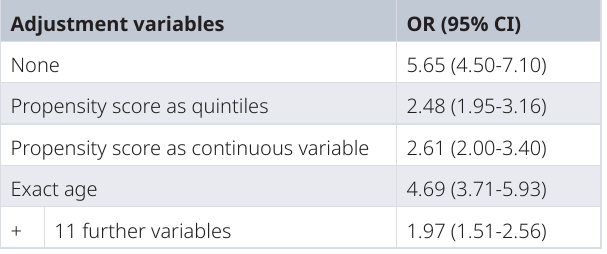
Table 6. Relating Wave 3 ever smoking to Wave 1 ever e-cigarette use using exact age.